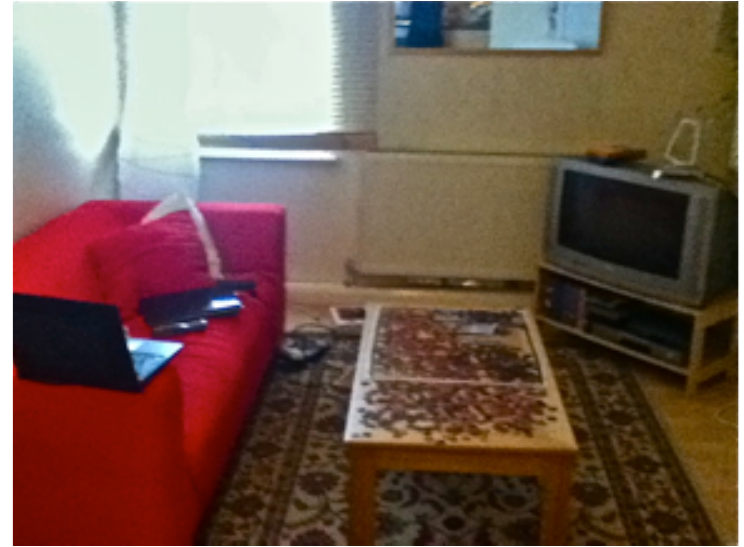
Figure 1: Juan’s temporary configuration of devices in his